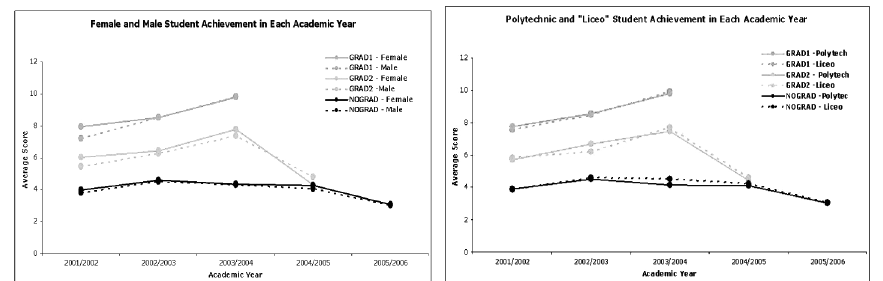
Figure 1 – Student performance for gender ( w 1 ) and type of diploma ( w 2